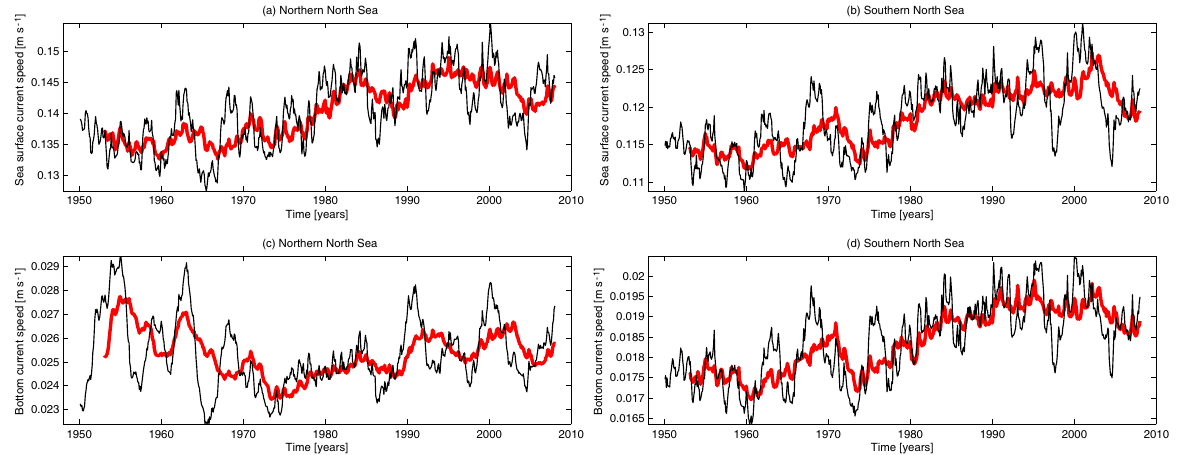
Figure 6. Northern (a, c) and southern (b, d) North Sea surface (a, b) and bottom current speed (c, d) . Displayed are monthly data as a 25-point moving average (black) and a 61-point moving average